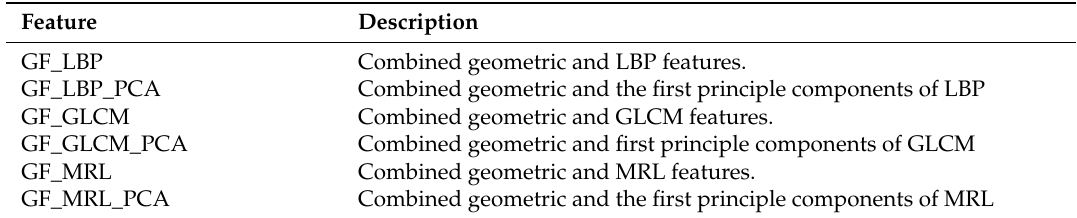
Table 6. Texture feature description.